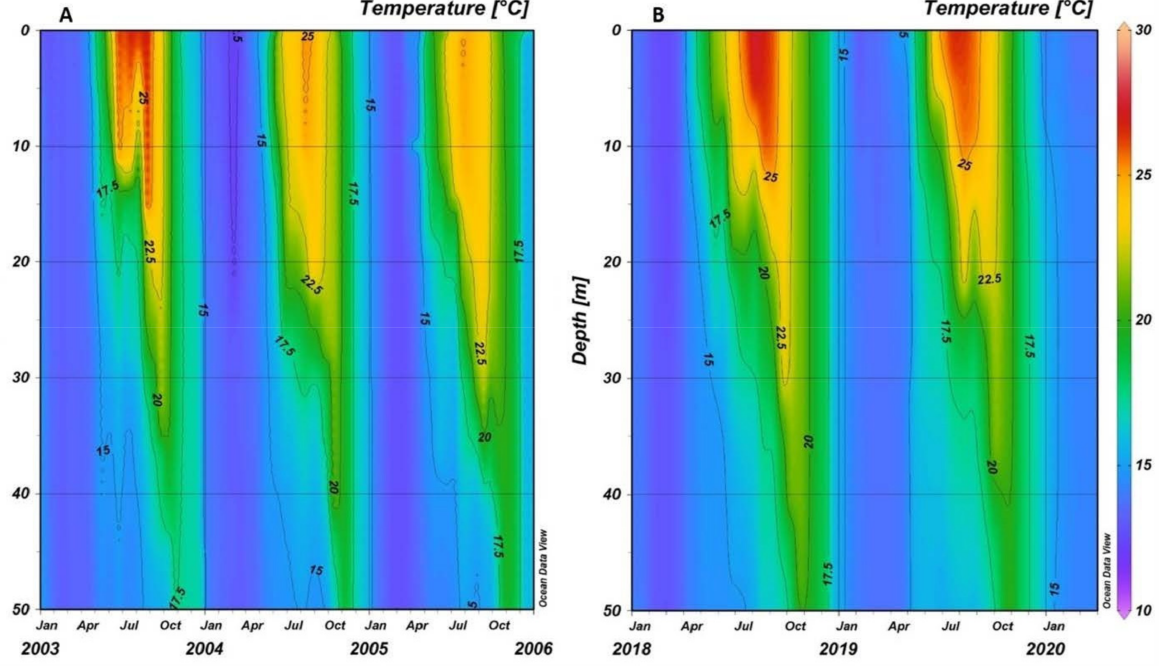
Figure 2. Temperature trend ( ◦ C) in the water column during the three years ( A ) and the two years ( B